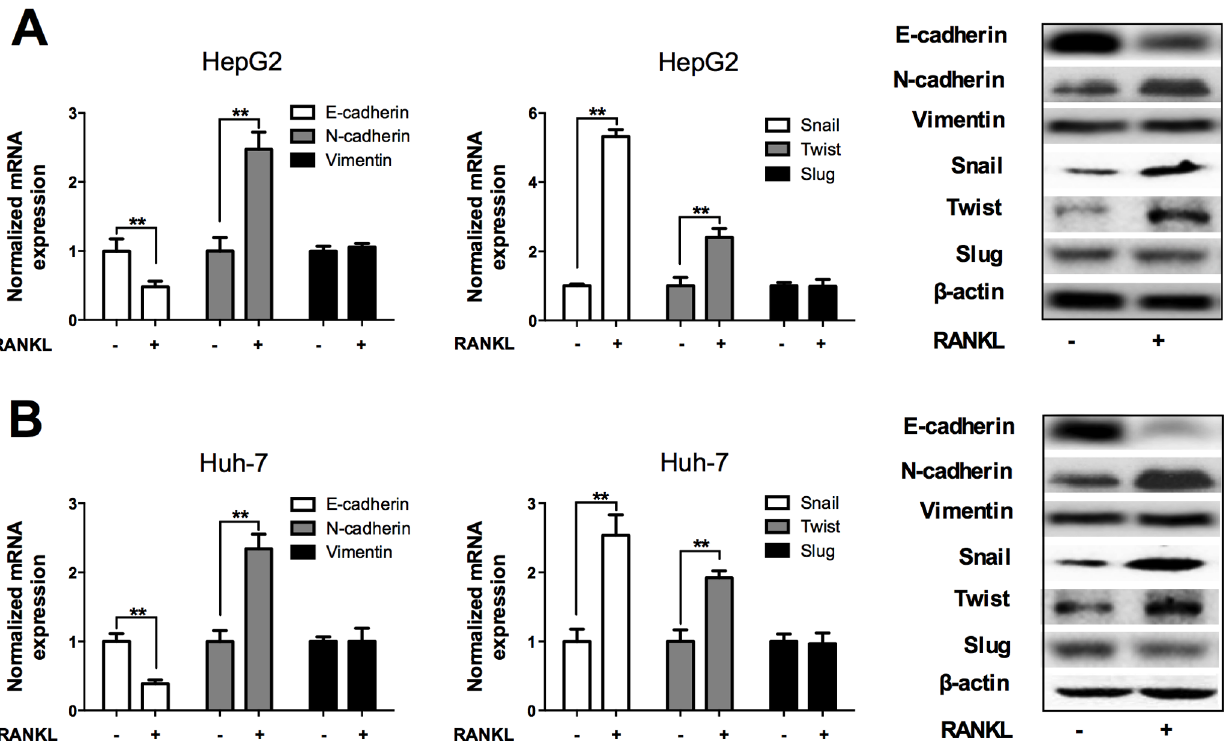
Figure 2. RANKL regulated the expression of EMT-related molecules in HCC cells. HepG2 and Huh7 cells were incubated with 100 ng/ml RANKL or PBS as control for 24 h. A. Both qRT-PCR and Western blot analyses revealed RANKL stimulation significantly promoted the expression of N- cadherin, Snail and Twist, inhibited E-cadherin, whereas the expression of vimentin and Slug did not show obvious changes. B. After treated with RANKL, Huh-7 showed a similar change in EMT markers as HepG2 cell. ** p , 0.01 compared with control.